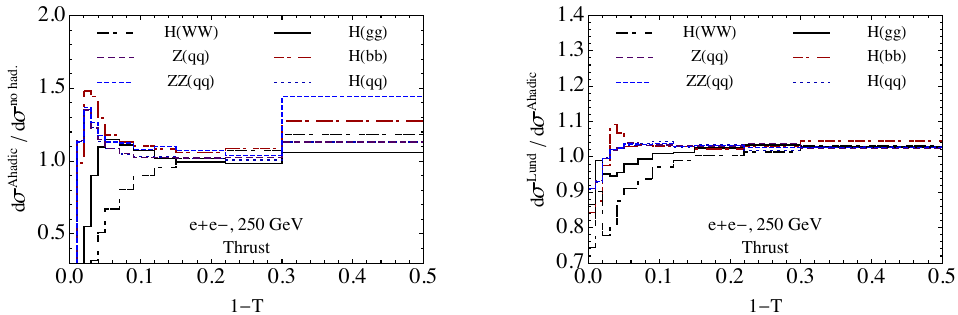
Figure 2 . Ratios of normalized distributions of thrust, left: predictions with AHADIC++ hadronization model to without hadronization corrections; right: predictions with Lund hadroniza- tion model to with AHADIC++ hadronization